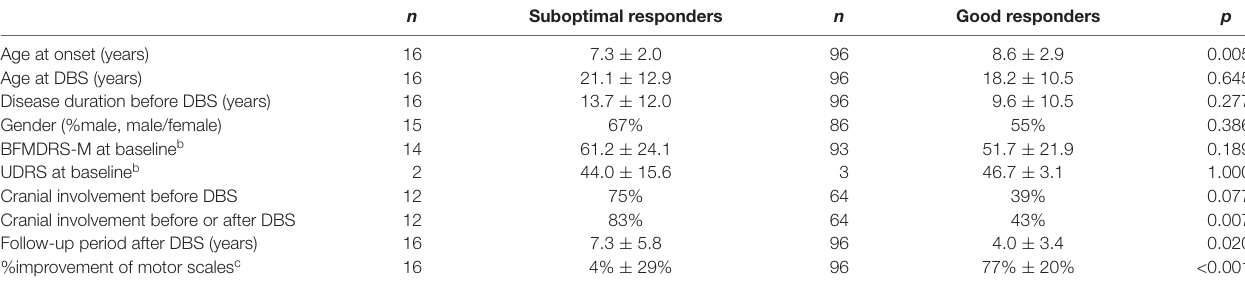
TABLE 3 | Comparison between the suboptimal and good responders of the historical cohort.